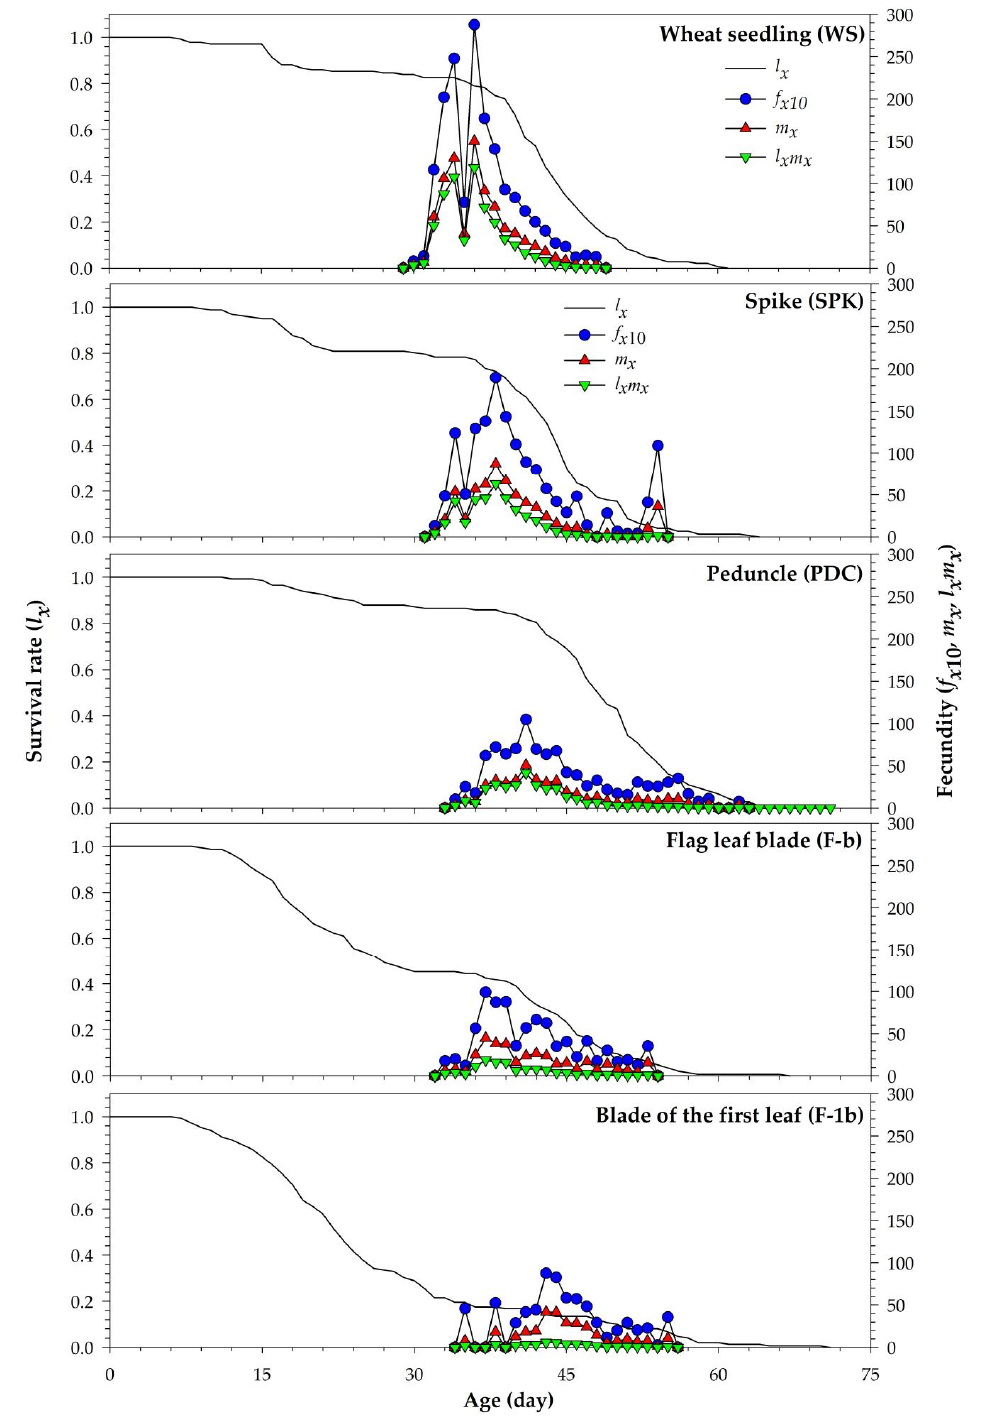
Figure 2. Age-specific survival rate ( l x ), female age-specific fecundity ( f x 10 ), age-specific fecundity of total cohort ( m x ), and age-specific maternity ( l x m x ) of the FAW fed on different wheat tissues. The life expectancy recorded under most of the treatments decreased with age, except for F-b or F-1b. For a new first instar fed on WS, SPK, PDC, F-b, and F-1b, it was 39.57, 38.47, 44.45, 29.76, and 23.28 d, respectively. However, the maximum life expectancy of the FAWs fed on F-b and F-1b was recorded at the pre-pupa (29.45) or pupa stage (33.22). This indicated that the larval stage had an important effect on life expectancy (Figure